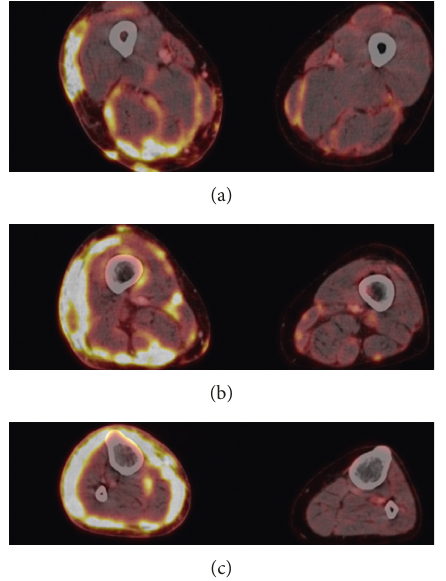
Figure 3: PET-CT showed pronounced inflammatory cutaneous changes of the entire circumference of the right leg and of fasciae surrounding several muscles. Minor inflammatory changes of the subcutis and muscle fasciae of the left leg are also present. (a) Upper part of thigh. (b) Lower thigh. (c) Upper part of lower